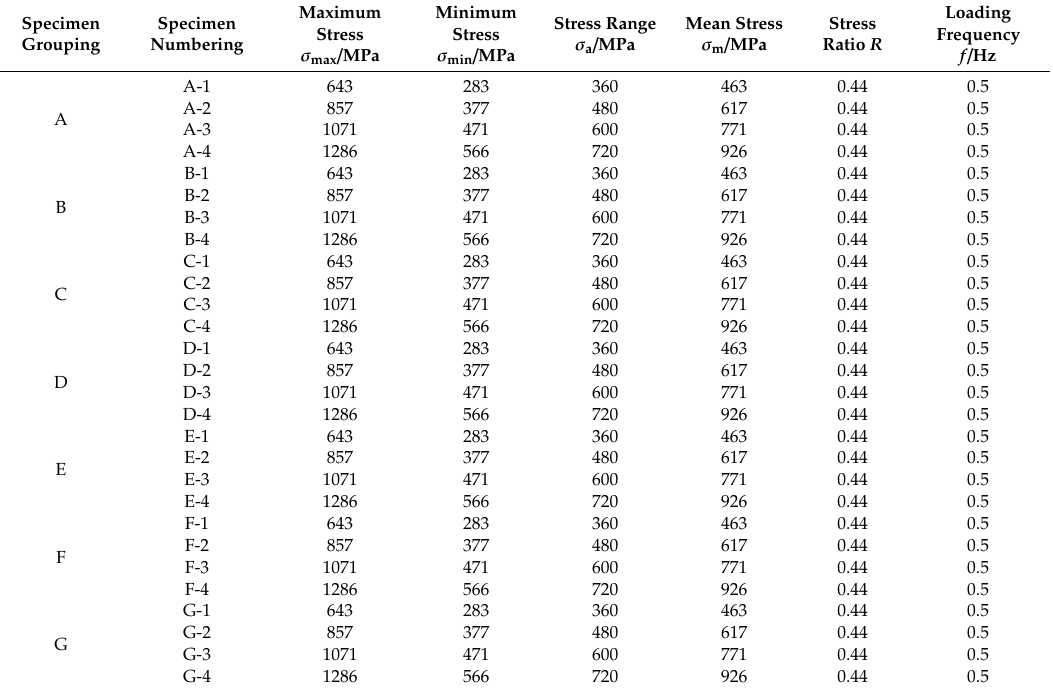
Table 3. Parameters of fatigue